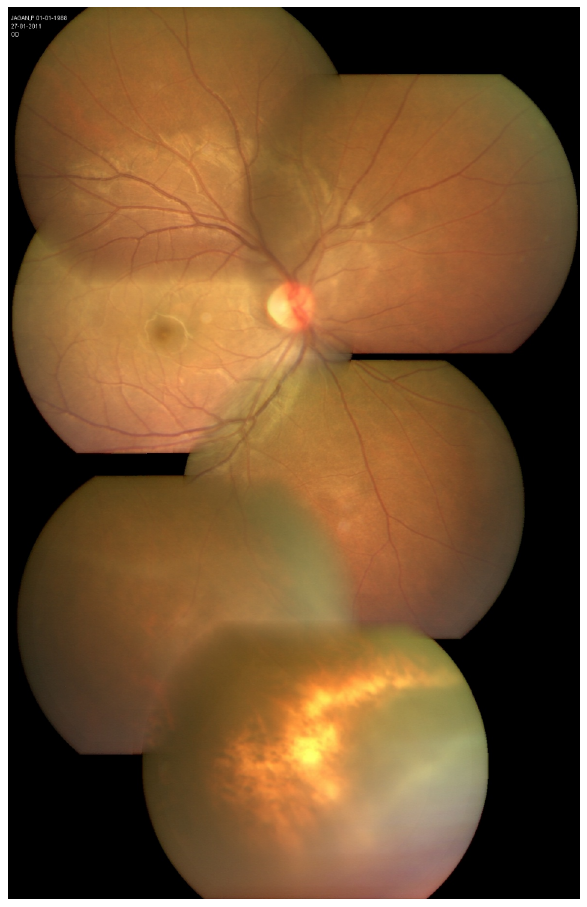
Figure 3: Three weeks after presentation.Color fundus montage of the right eye reveals minimal media haze overlying the affected quadrant with an area of chorioretinal